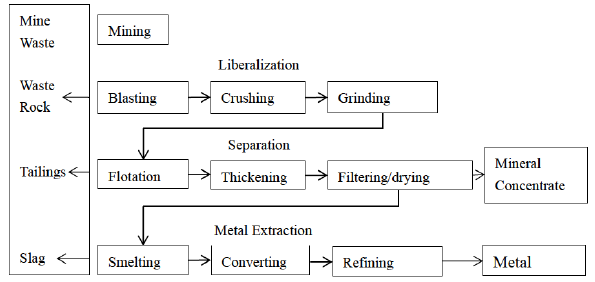
Figure 1: Mineral extraction from mining to metal